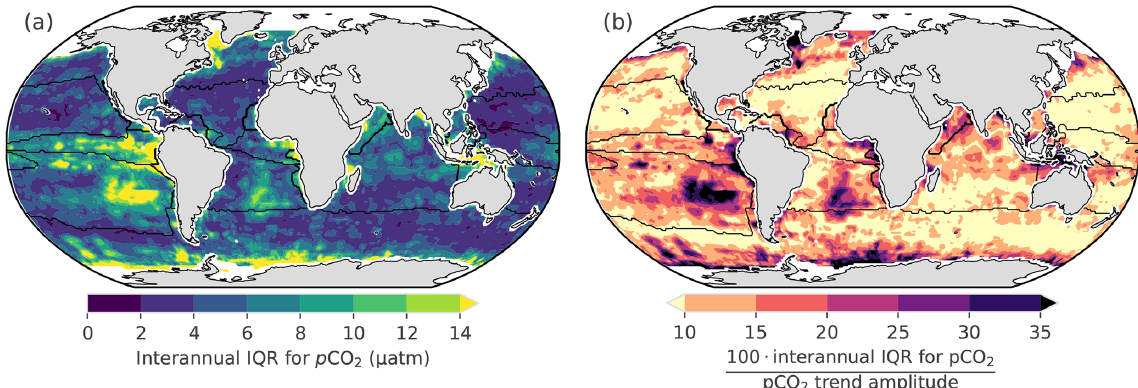
Figure 11. (a) The magnitude of the interannual disagreement between independent gap-filling methods (IQR IA ) as shown in Fig. 10; hence, low IQR IA indicates good agreement amongst the different methods. (b) Level of agreement on the interannual variability across methods (in %), more specifically IQR IA scaled by the difference between the maximum and minimum values for interannual p CO 2 (the range).